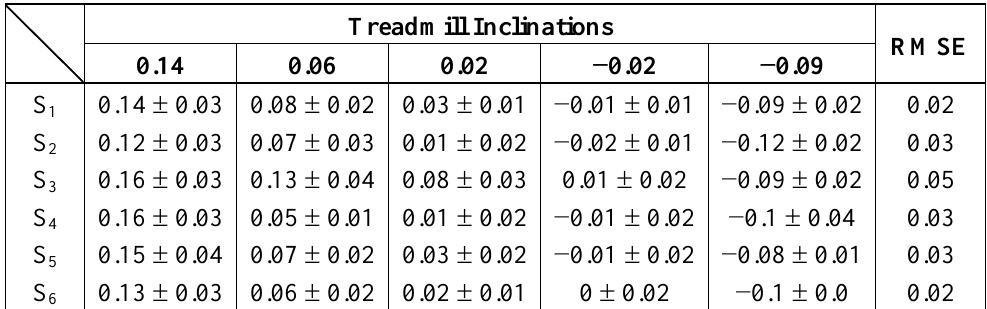
Table 3. Corrected estimations using a linear model for each user defined from experiments at 0.1 and −0.05 and applying a moving average filter to raw estimations. Average and standard deviation at every inclination but those used for calibration purposes are shown. Root Mean Squared Error (RMSE) of estimations is also shown for each subject. S stands for Subject n